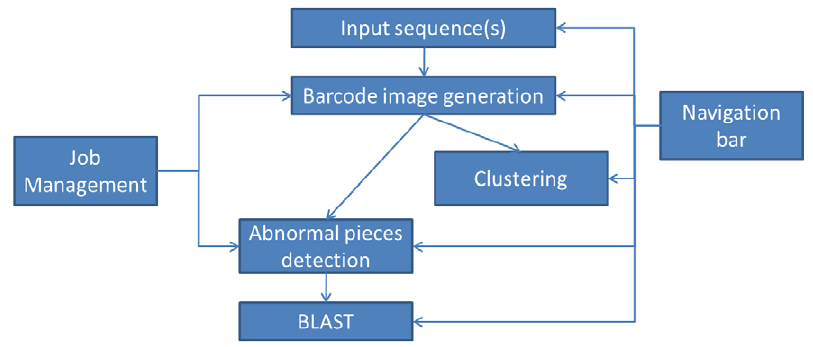
Figure 1. Webserver organization.